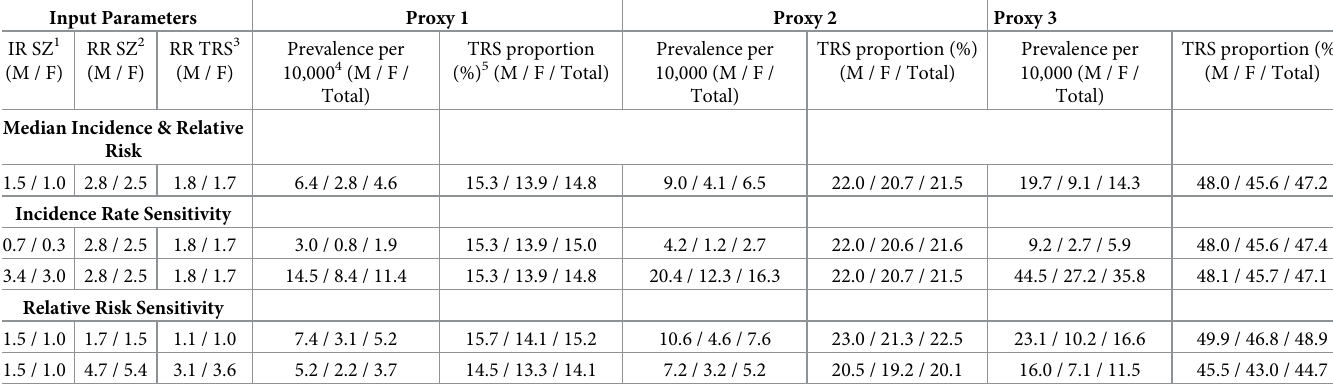
Table 1. TRS prevalence results estimated using the IPM-model for USA